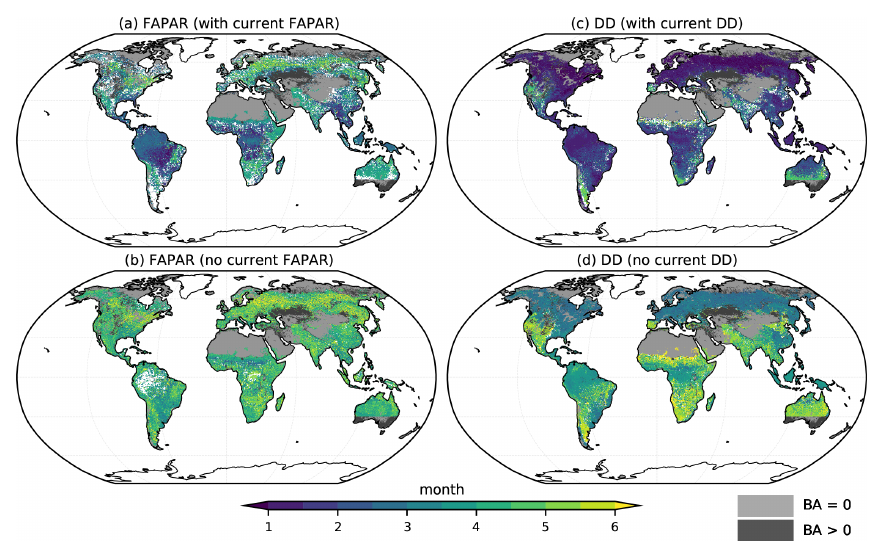
Figure 7. Timescales of influence of FAPAR and DD on BA. The plots show the period that is most important for determining BA from the 15VEG_FAPAR model for (a) FAPAR and (c) DD. Plots (b) and (d) show which antecedent period is most important by disregarding the influence of current conditions during plotting. Moister biomes are seen to be more influenced by current FAPAR (a) , while current DD has a large influence globally (c) . Note that the maps give no indication about the sign of the influence of the predictor on BA (see Fig. S10). Note also that sharp data availability boundaries (e.g. in western Asia, southern Australia) are introduced by the AGB dataset. Grey shading indicates regions with fire data availability but where one or more of the other datasets is not available. Light grey indicates regions where mean BA is 0, with dark grey representing regions with non-zero mean